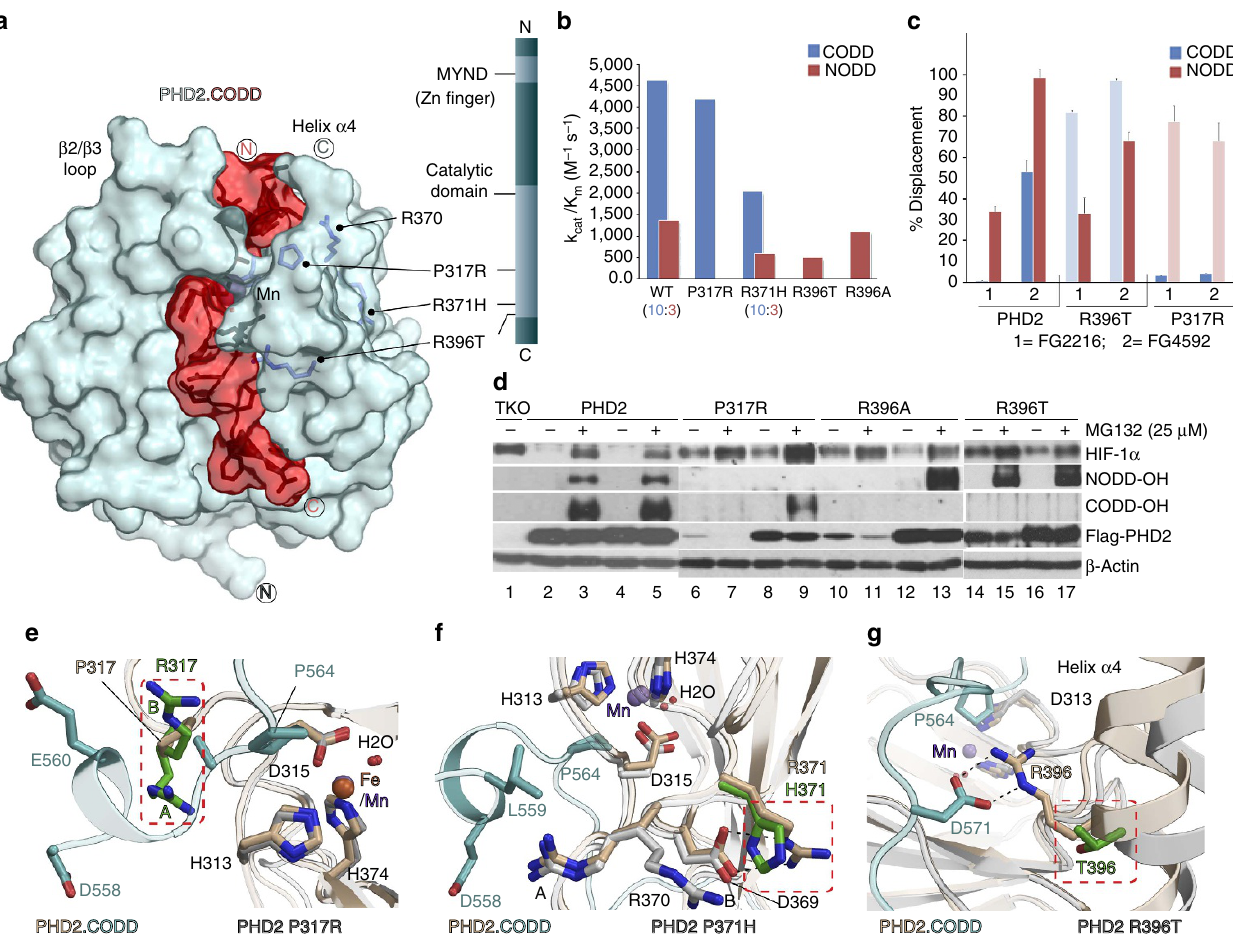
Figure 2 | Clinically observed variants in PHD2 have altered selectivities. ( a ) View from the PHD2.CODD complex (PDB: 3HQR) showing locations of PHD2 clinical variants with altered ODD selectivities. ( b ) Kinetic analyses show the P317R and R396X variants are highly selective for CODD and NODD, respectively; R371H is less efficient at the same CODD/NODD activity ratio (10:3) as wt PHD2 with (almost) unaltered selectivity. k cat / K m values are calculated from the average k cat and K m values (Supplementary Table 3). ( c ) One-dimensional 13 C-selective clean in-phase (CLIP)–HSQC NMR reveals apparently selective displacement of NODD/CODD from PHD2 wt/clinical variant complexes by using PHD inhibitors (FG2216/ FG4592) (Supplementary Fig. 13). n ¼ 5 for wt and 2 for variants. ( d ) Selectivity studies using hydroxy-proline antibodies (NODD-OH and CODD-OH) and PHD 1–3 TKO MEF